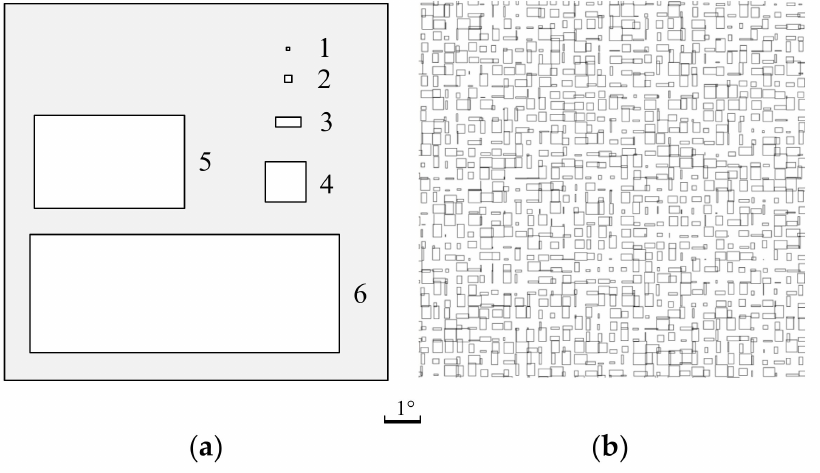
Figure 6. Six query rectangles and the simulated dataset. ( a ) Six query rectangles. The number near each rectangle is its ID. The outside rectangle denotes the extent of the simulation dataset. ( b ) Magnified view of rectangle ‘1’ in the simulated